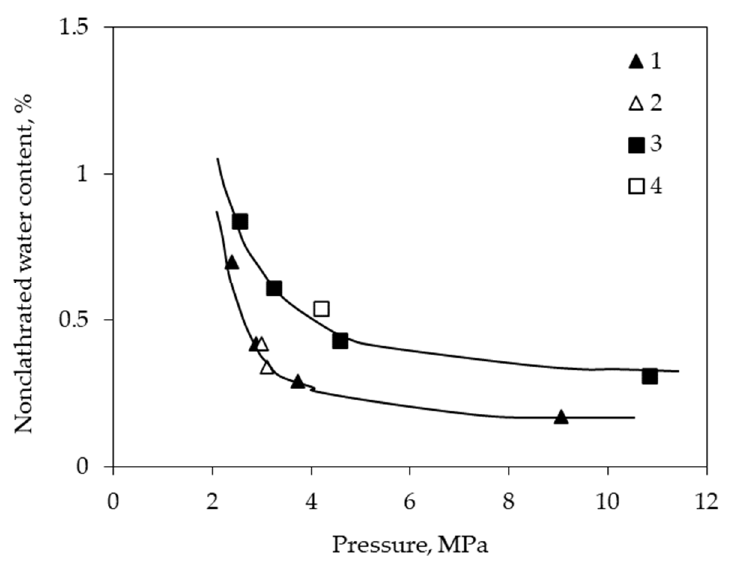
Figure 3. Change of nonclathrated water content depending on methane pressure in artificial sediment mixtures: sand with 14% (1, 2) and 25% (3, 4) kaolinite particles at 268.15 K. 1,3—Calculated data and 2,4—experimental data. P eq = 2.36 MPa (CH 4 ).